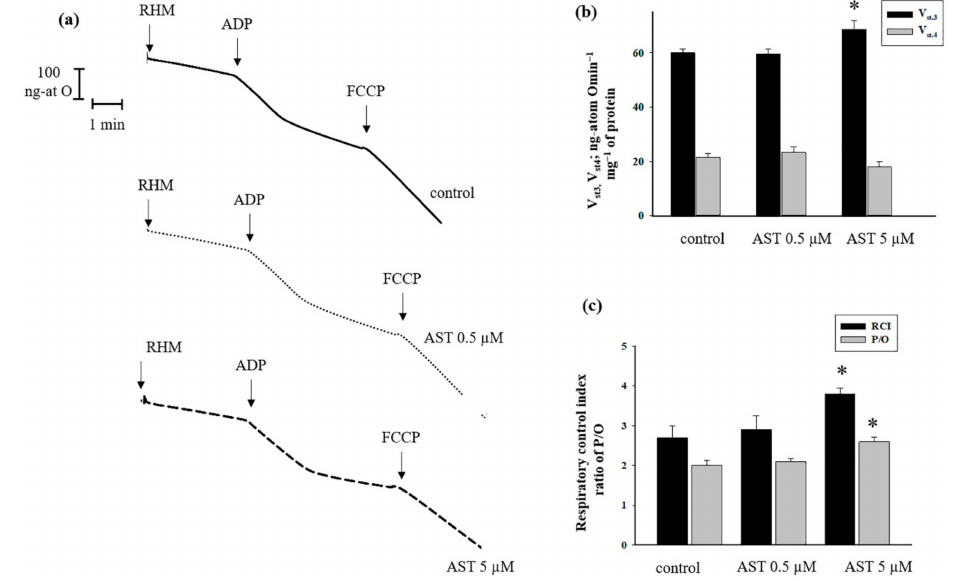
Figure 1. The E ff ect of astaxanthin (AST) on respiratory activity in rat heart mitochondria (RHM). RHM were incubated in standard medium as described in Materials and Methods. Arrows show the times at which FCCP (Carbonyl cyanide 4-(trifluoromethoxy) phenylhydrazone) and ADP (adenosine 5 ‘-diphosphate) were added. ( a ) Curves of respiratory activity; ( b ) quantitative analysis of RHM respiration rate in states 3 and 4 in the absence / presence of AST (0.5 and 5 µ M); ( c ) values of respiratory control index (RCI) and phosphate / oxygen (P / O) ratio in the presence / absence of AST. Data are presented as means ± SDs of five independent experiments. * p < 0.05 compared with control (without